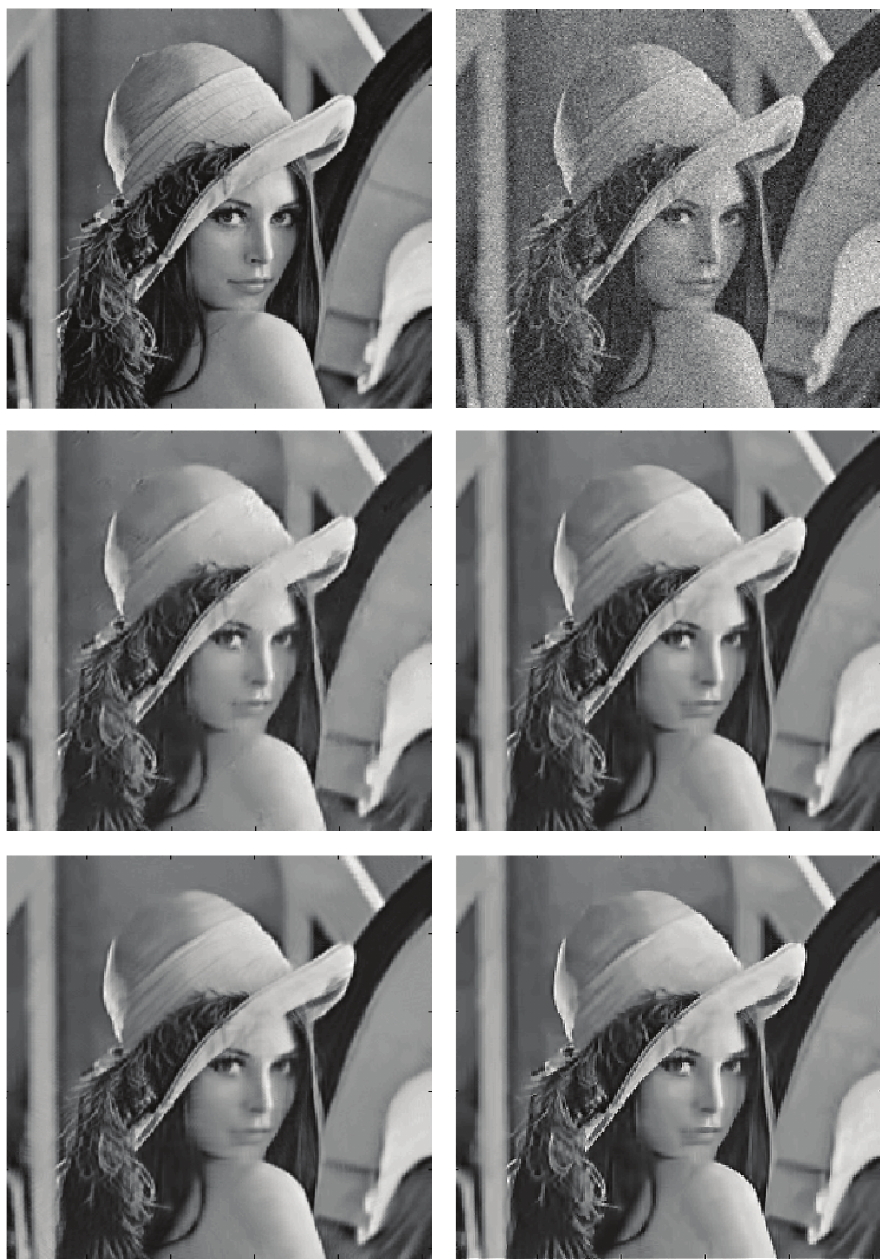
Figure 5: The denoising results of Lena by different schemes with 𝜎 = 20